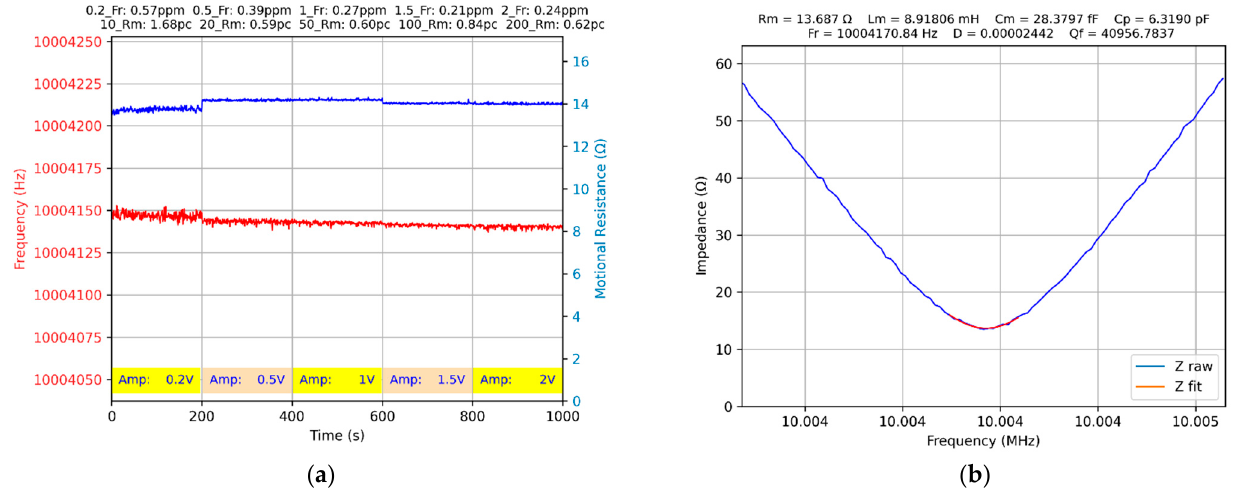
Figure 7. The QCM sensor measured in air with 10 Hz step: ( a ) drive level dependence, ( b ) series resonant frequency tracking with 0.2 V sine wave amplitude.